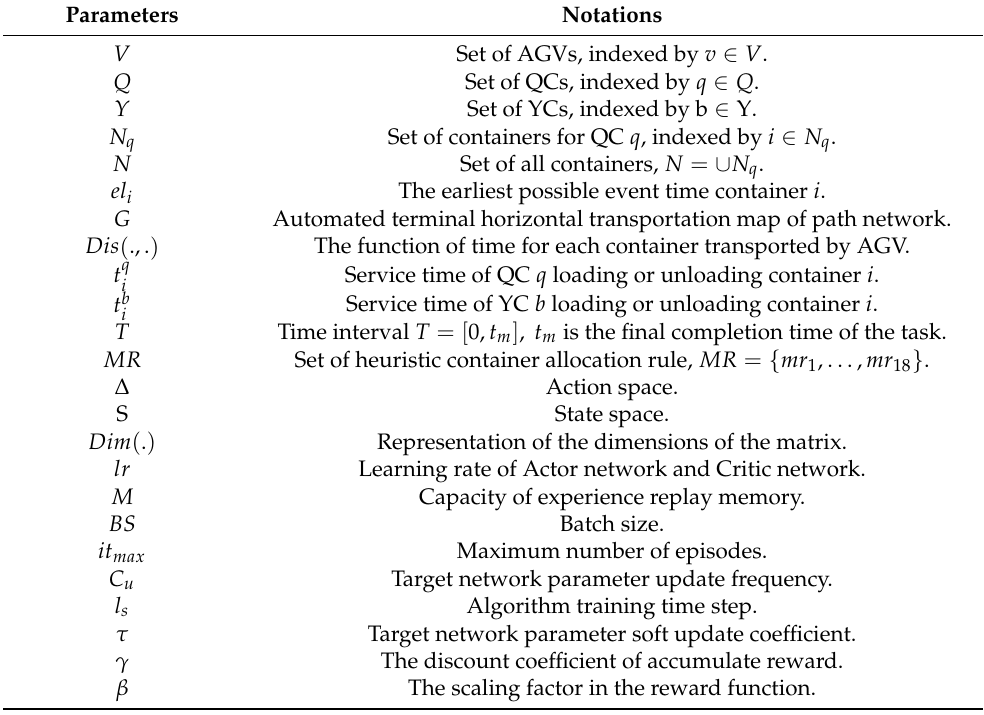
Table 1. Parameter notations.